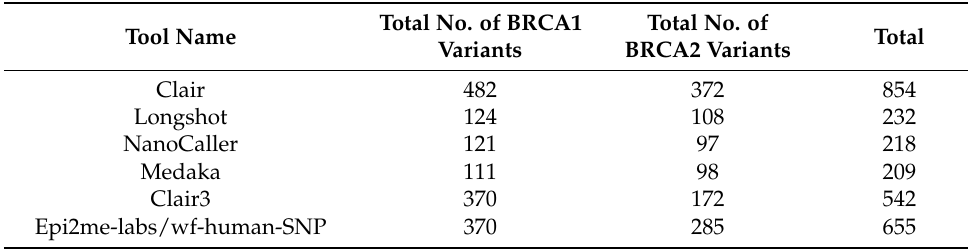
Table 4. The total no. of the output variants (SNPs, INDELs, and MNPs) of the six variant callers in comparison to both BRCA1 and BRCA2 genes in the HG002.